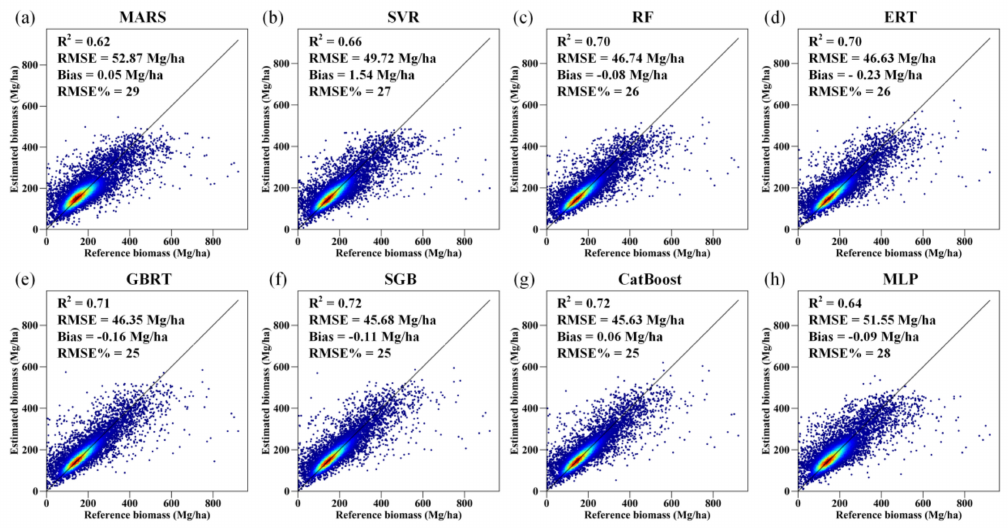
Figure 7. Density scatter plot of the predicted AGB results obtained by the MARS, SVR, RF, ERT, GBRT, SGB, CatBoost, and MLP models ( a – h ) for 50 runs under the random sampling